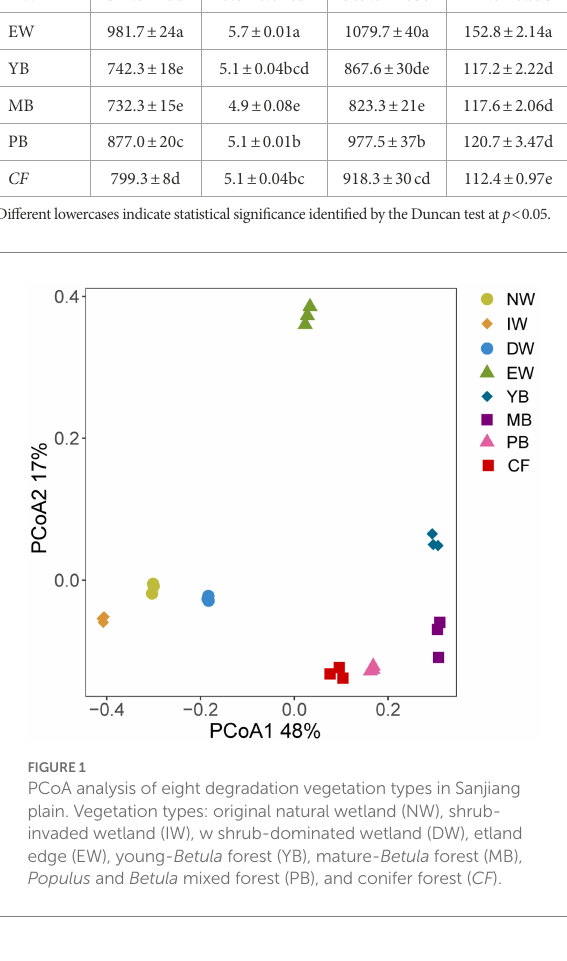
TABLE 3 Adonis analysis of the difference or similarity in Acidobacterial community between the wetland group and forest group in a degraded wetland of Sanjiang plain.